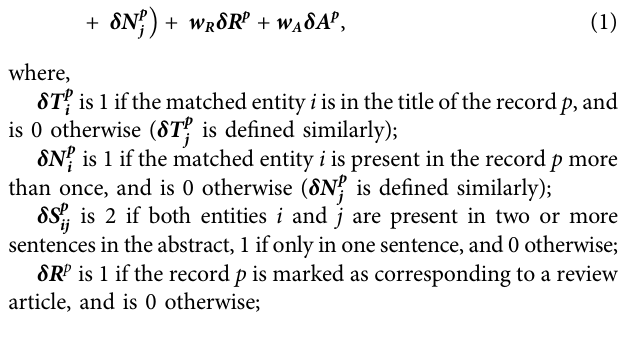
algorithm (Needleman and Wunsch, 1970) with weight: 1 for exact matches, and − 1 for mismatches and gaps. For two aligned entities